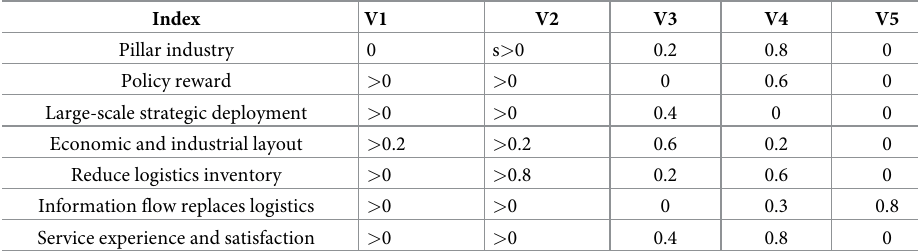
Table 8. Comprehensive membership score.